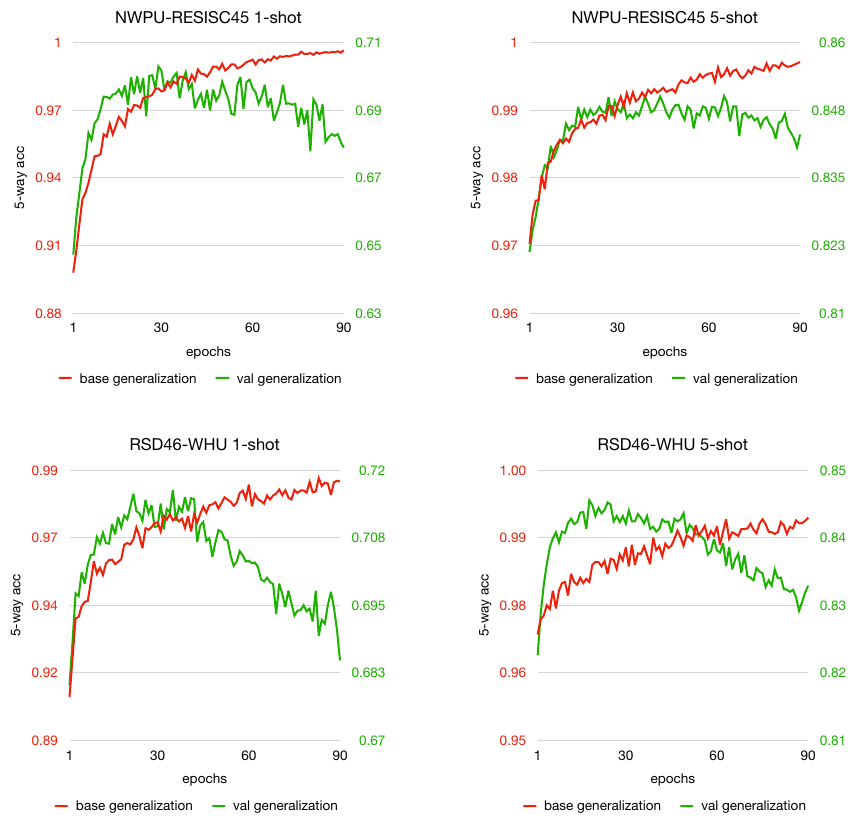
Figure 10. Generalization curves of the proposed method on meta-train and meta-val sets with respect to the number of training epochs. The 5-way classification accuracy with 1-shot and 5-shot at each epoch is